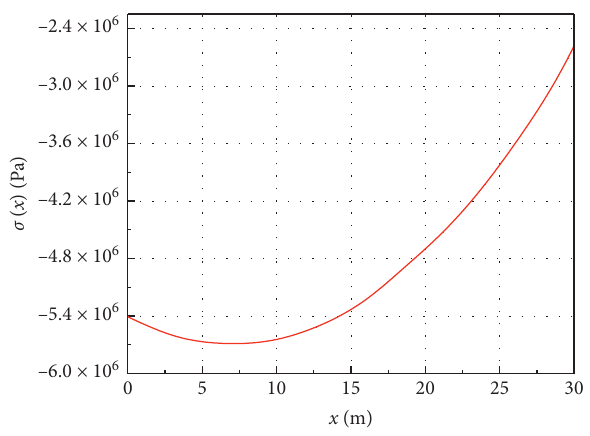
Figure 4: The variation of bending stress (I).